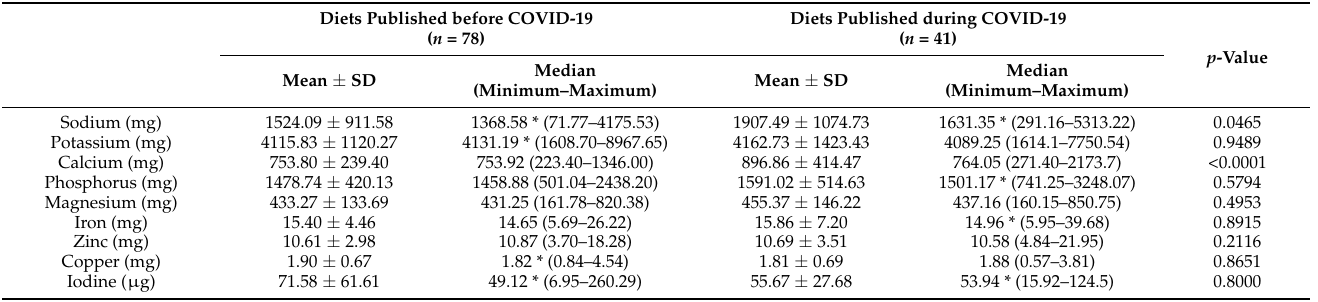
Table 5. The mineral intake within the assessed single-day menus, stratified by year of publication, for the diets published before the COVID-19 pandemic and the diets published during the COVID-19 pandemic.